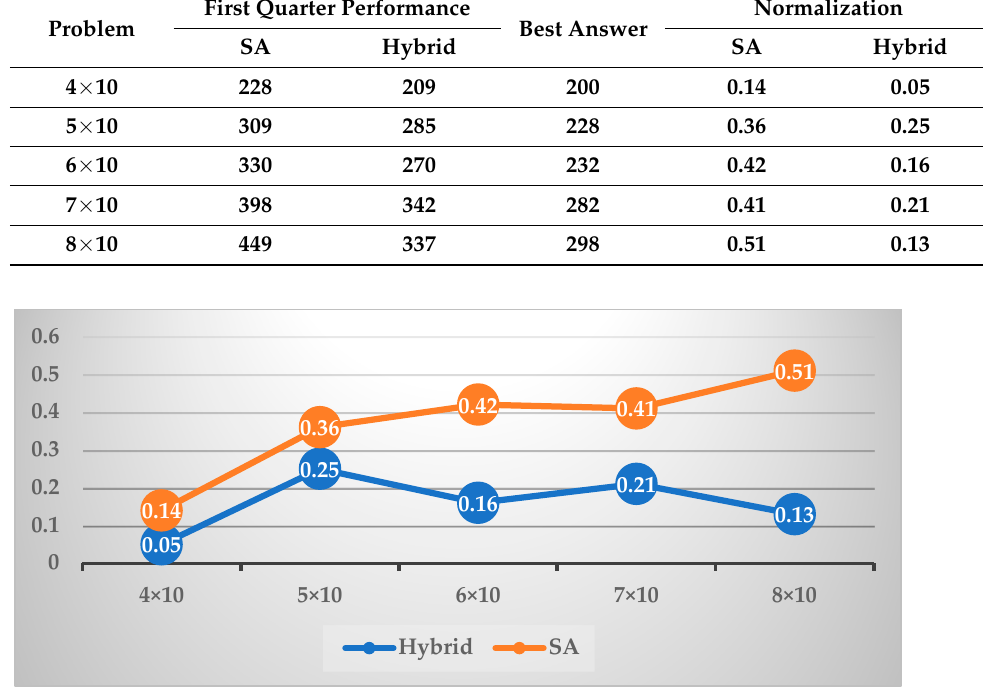
Figure 13. Fitness diagram of SA and hybrid SA in the first quarter (10 ORs). Table 4. Results of executing the SA and hybrid SA algorithms in the first quarter (15 ORs) .